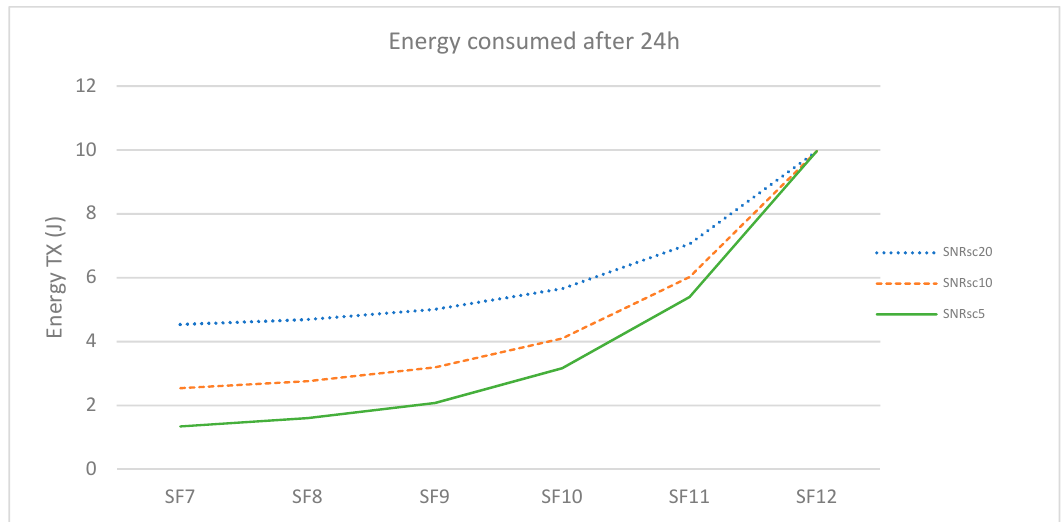
Figure 12. Energy consumed by transmissions depending on the SF reached by the ED for 24 h.